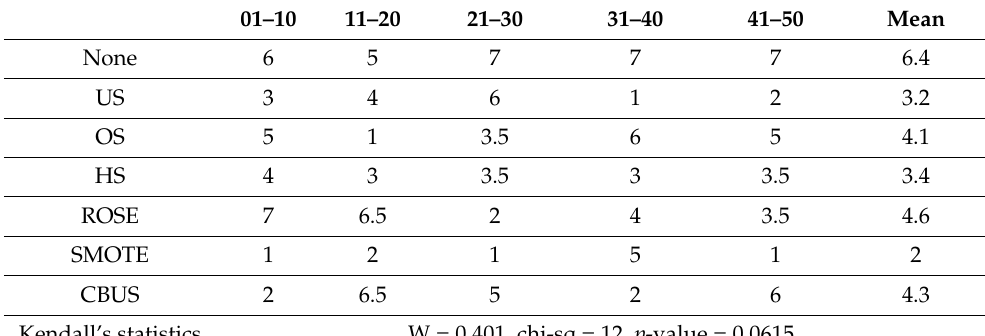
Table 17. Ranks of DBT for LR for varying levels of